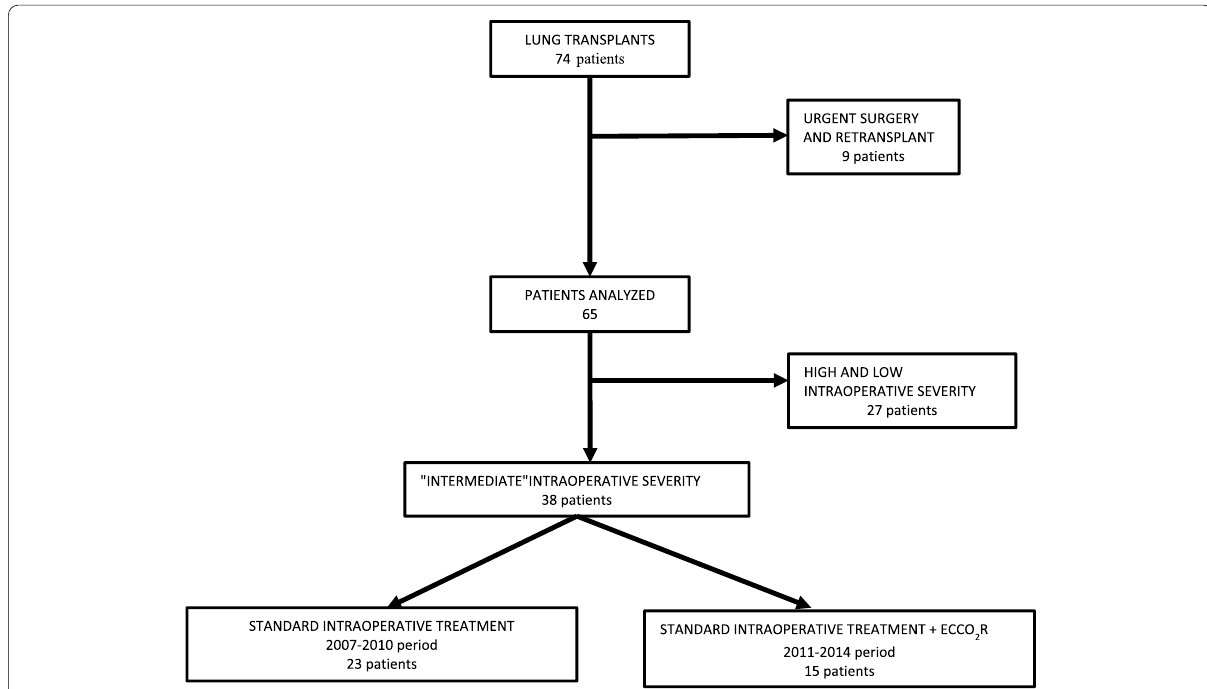
Fig. 1 Flow-chart of the study protocol. Legend: Between November 2007 and March 2014, 74 patients underwent lung transplantation, and 9 of these were excluded from the study because of urgent surgery or retransplant. Out of the remaining 65 patients, 38 presented “intermediate” intraoperative severity: 23 patients in the 2007–2010 who “received standard intraoperative treatment,” 15 patients in the 2011–2014 who received “standard intraoperative treatment extracorporeal carbon dioxide removal (ECCO 2 R). “Intermediate” intraoperative severity: patients who + developed intraoperative severe respiratory acidosis with maintained oxygenation function (i.e., pH <7.25, paCO 2 >60mmHg PaO 2 /FiO 2 >150), not associated with hemodynamic